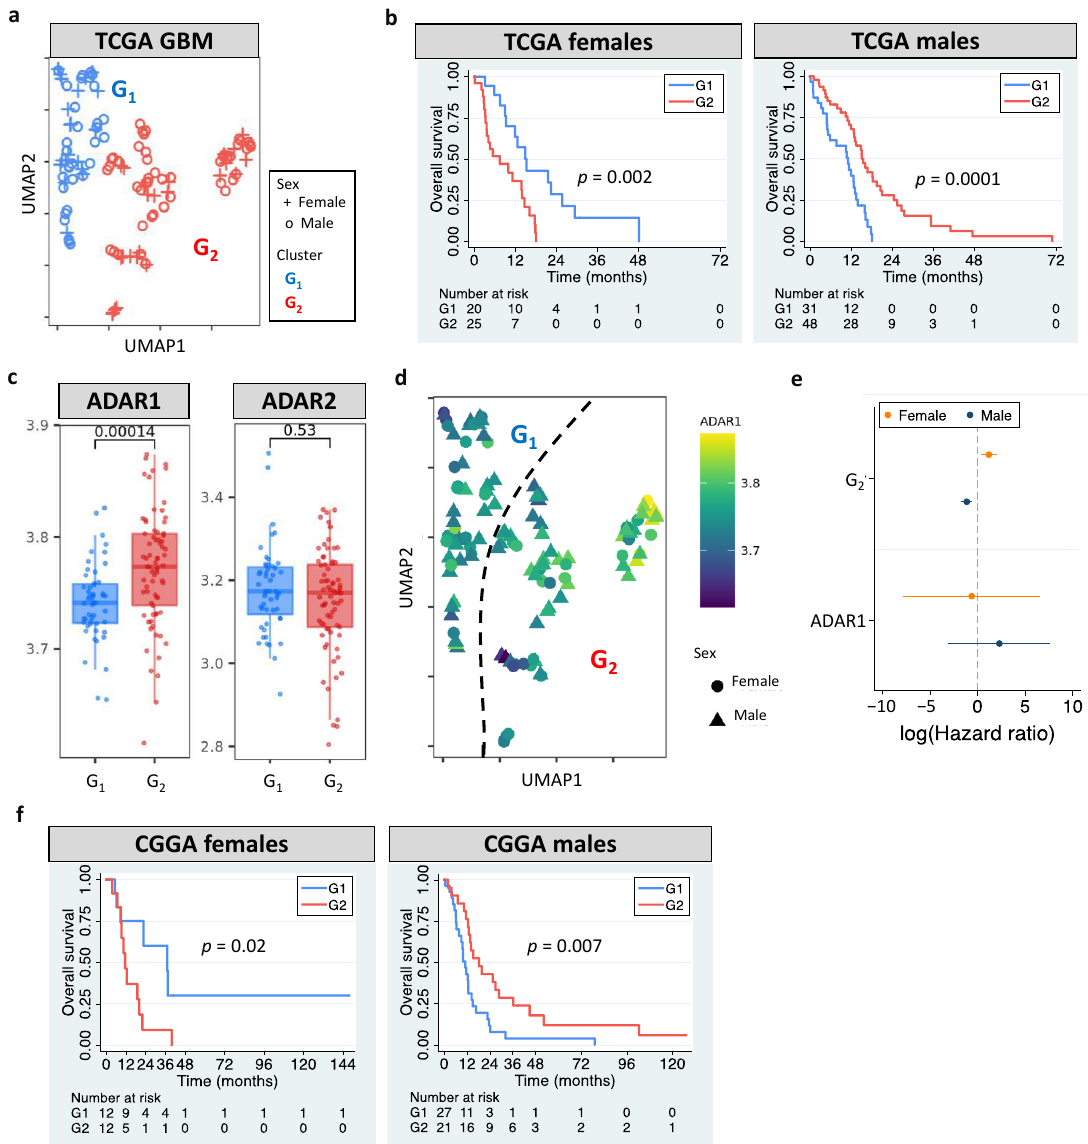
Figure 1. RNA editing-based subtyping of GBM samples. ( a ) UMAP of TCGA GBM samples (G 1 and G 2 ). ( b ) Kaplan–Meier (KM) curves for UMAP clusters (G 1 and G 2 , log-rank test). ( c ) ADAR1 / ADAR2 expression of G 1 and G 2 . ( d ) UMAP of GBM samples colored based on ADAR1 expression. ( e ) Cox’s hazard ratios (HRs) of G 2 and ADAR1 expression for GBM survival. ( f ) KM curves for G 1 and G 2 of CGGA GBM samples. Dashed line indicates HR of 1.